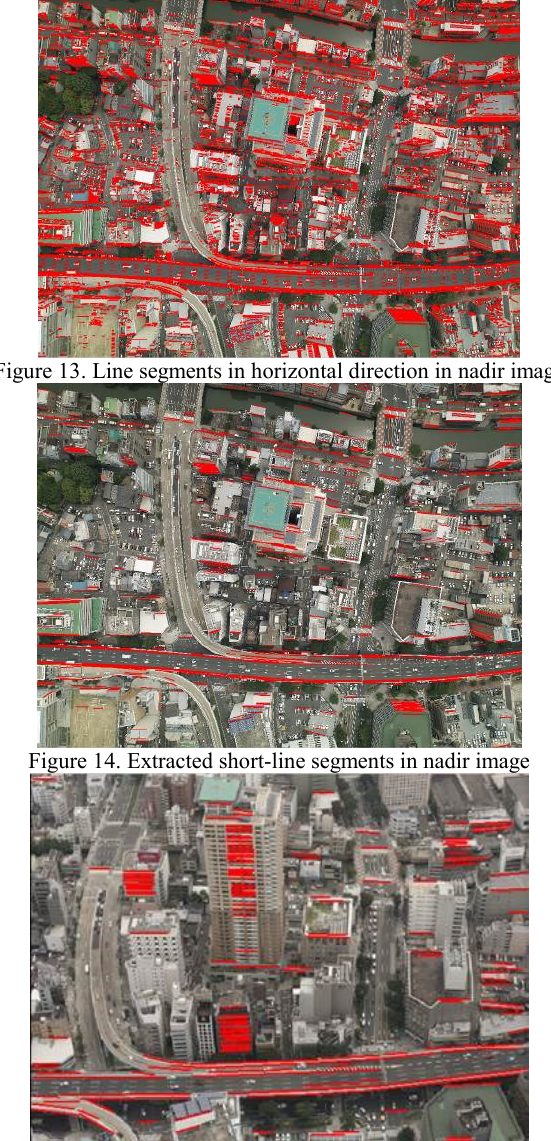
Figure 15. Filtered short-line segments in forward image